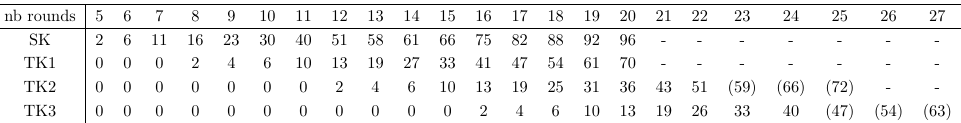
Table 2: Step 1 objectives in skinny . The objectives in parenthesis are upper bounds, the computations were stopped after 1 day on 32